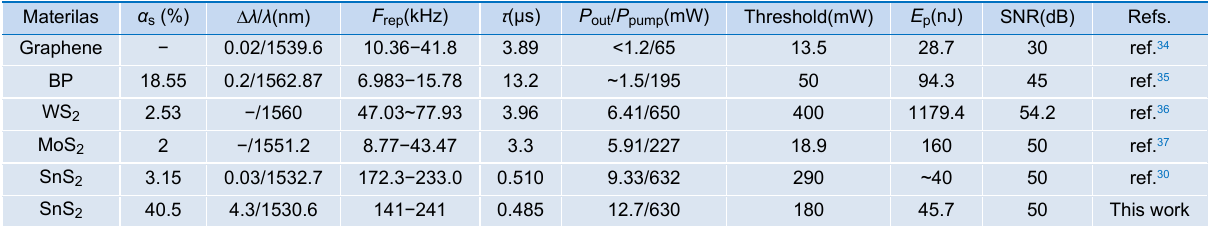
Table 2 | Comparison of QSFL based on various